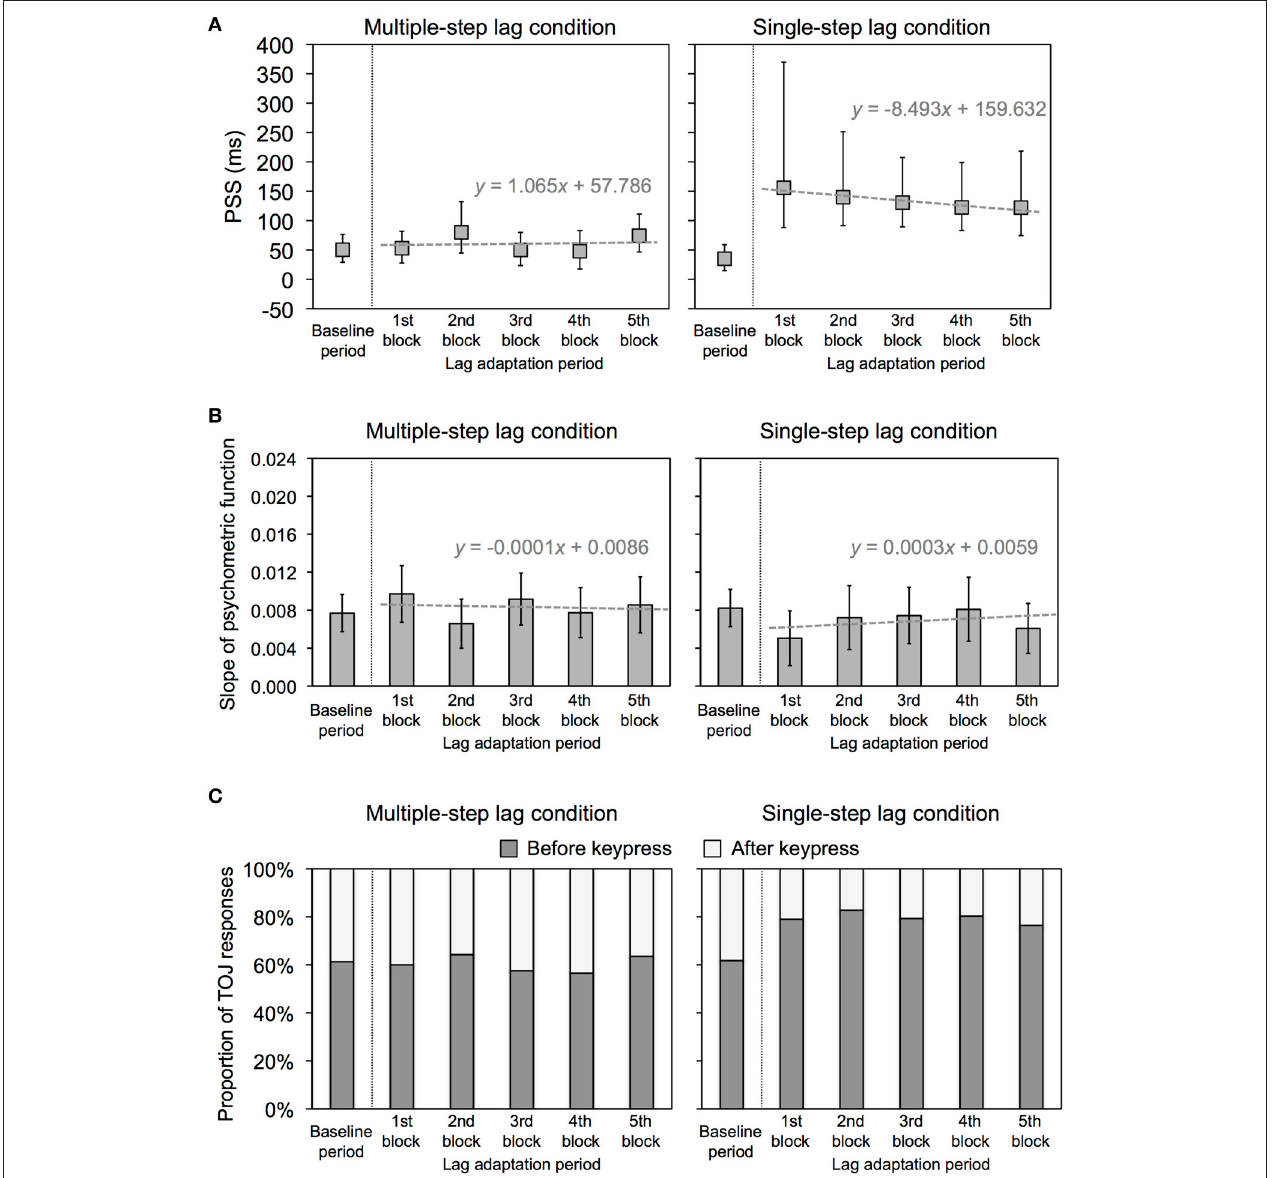
FIGURE 3 | Results of Experiment 1. (A) PSS for multiple-step and single-step lag conditions in Experiment 1. Positive values in the PSS show that a test flash was presented after the sixth keypress. Error bars show a 95% confidence interval obtained from Probit analysis. Dotted gray lines show regression lines fitted to the PSSs at the lag adaptation blocks, with regression equations. (B) Slope of psychometric function for multiple-step and single-step lag conditions in Experiment 1. Error bars show a 95% confidence interval obtained from Probit analysis. Dotted gray lines show regression lines fitted to the PSSs at the lag adaptation blocks, with regression equations. (C) Proportion of TOJ responses for multiple-step and single-step lag conditions in Experiment 1. Dark and light gray bars respectively represent the response that a test flash was perceived before and after the sixth